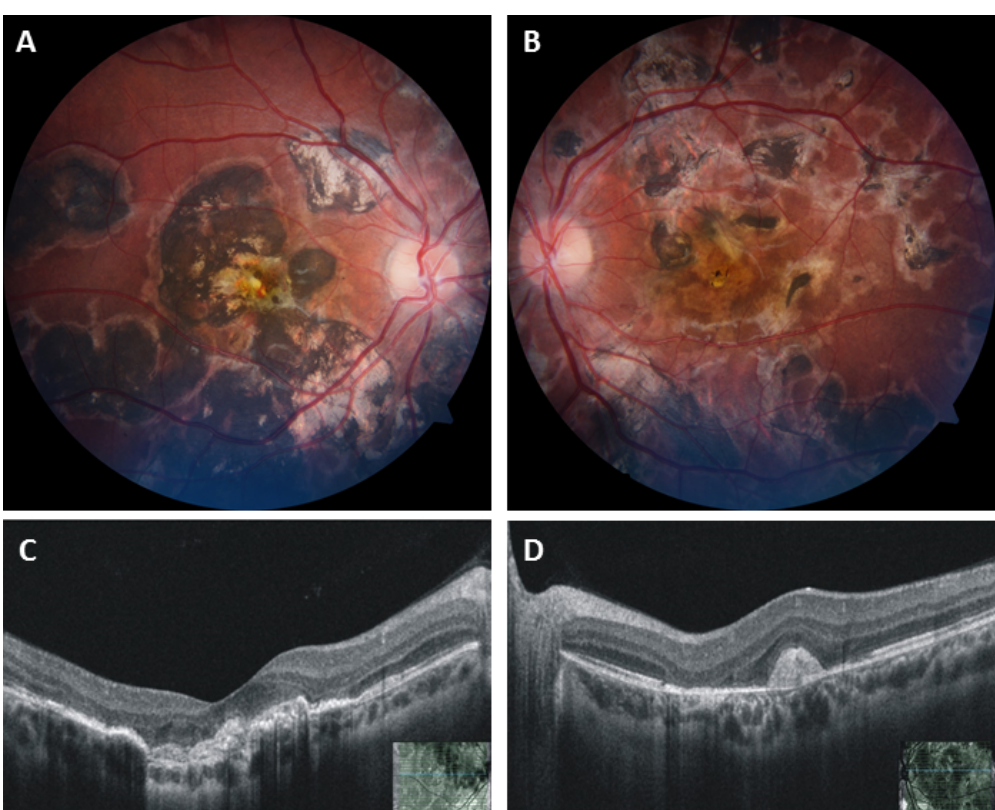
Figure 3: Follow-up fundus photo of the right eye (A) and the left eye (B) at six months showing near total resolution of hemorrhage in the right eye and subfoveal scar in both eyes. OCT at final follow-up after six months in the right eye (C) and the left eye (D) reveals an organized subfoveal scar in both eyes without any surrounding edema or